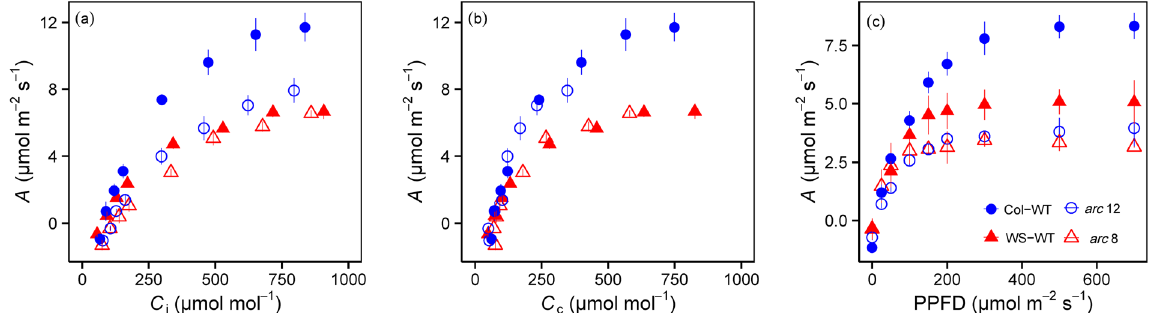
Figure 2. A /C i ( a ), A /C c ( b ) and light ( c ) response curves of the mutants and their wild-types. The values shown are the mean ± SD of three